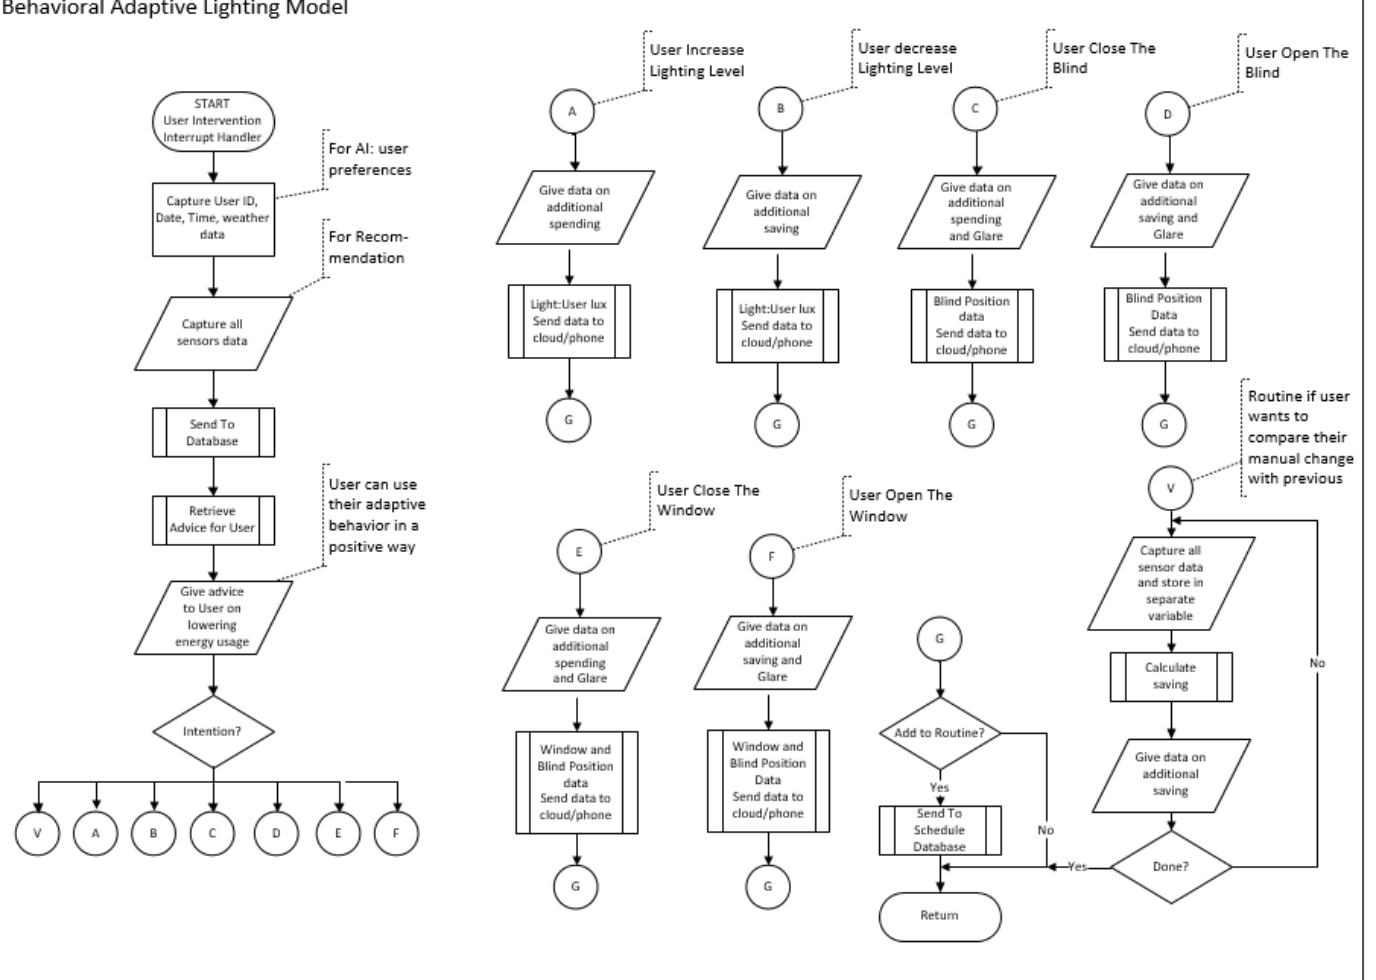
Figure 3. The adaptive lighting model flow.